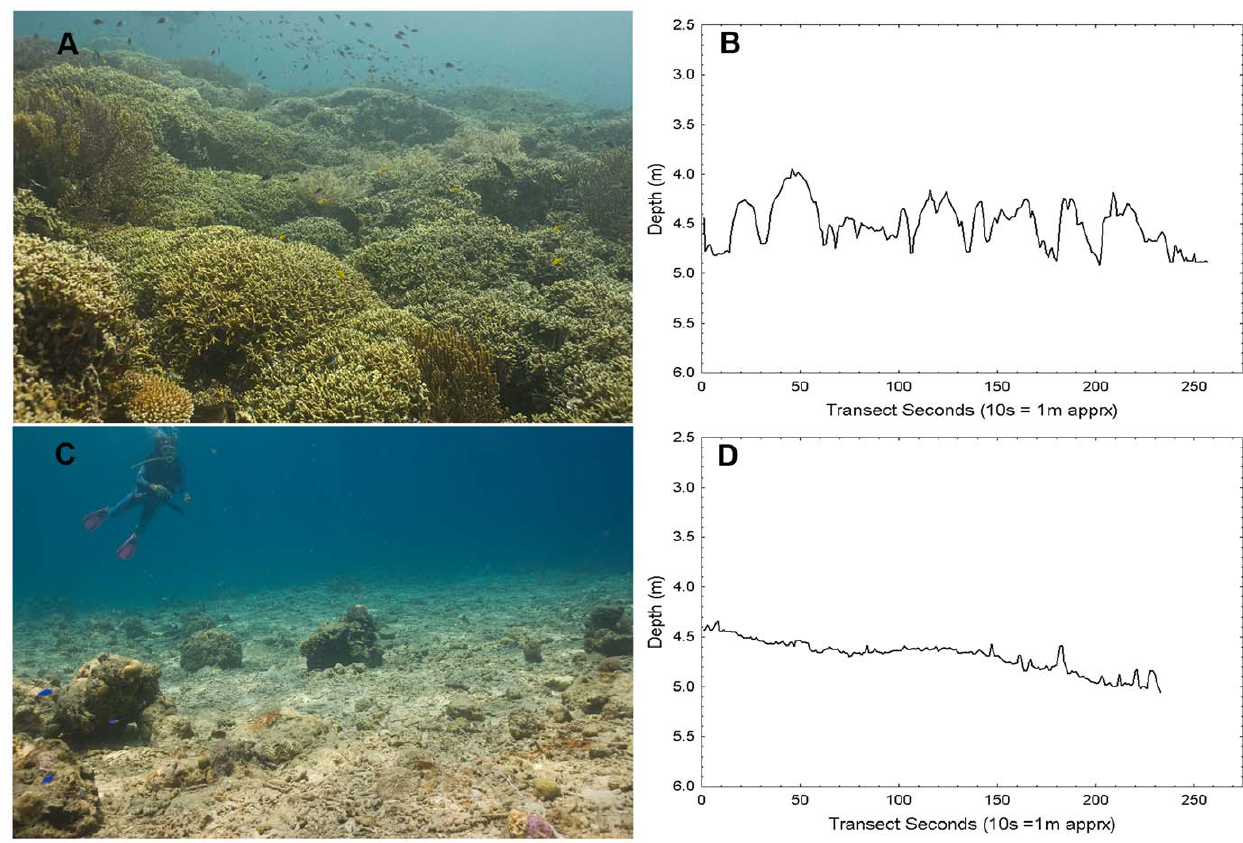
Figure 3. DRR transects in rich reef and adjacent rubble sites at Kelor Point. The fringing reef at Kelor Point alternates between rich undamaged coral reef (KEL2-SC (A and B)) and barren unstable rubble (KEL1-SR (C and D)). The peaks along the rich coral DRR transect (B) reflect the contribution coral colonies make to the canopy morphology. A comparison of the two DRR transects (B and D) illustrates the contribution live coral make to the reef canopy profile. The difference in depth between these two transects approximates the biovolume of the living reef. The transects are nearly equal in linear length, but the rubble transect contains fewer points because it took less time to swim (Table 5). (photos P Dustan).